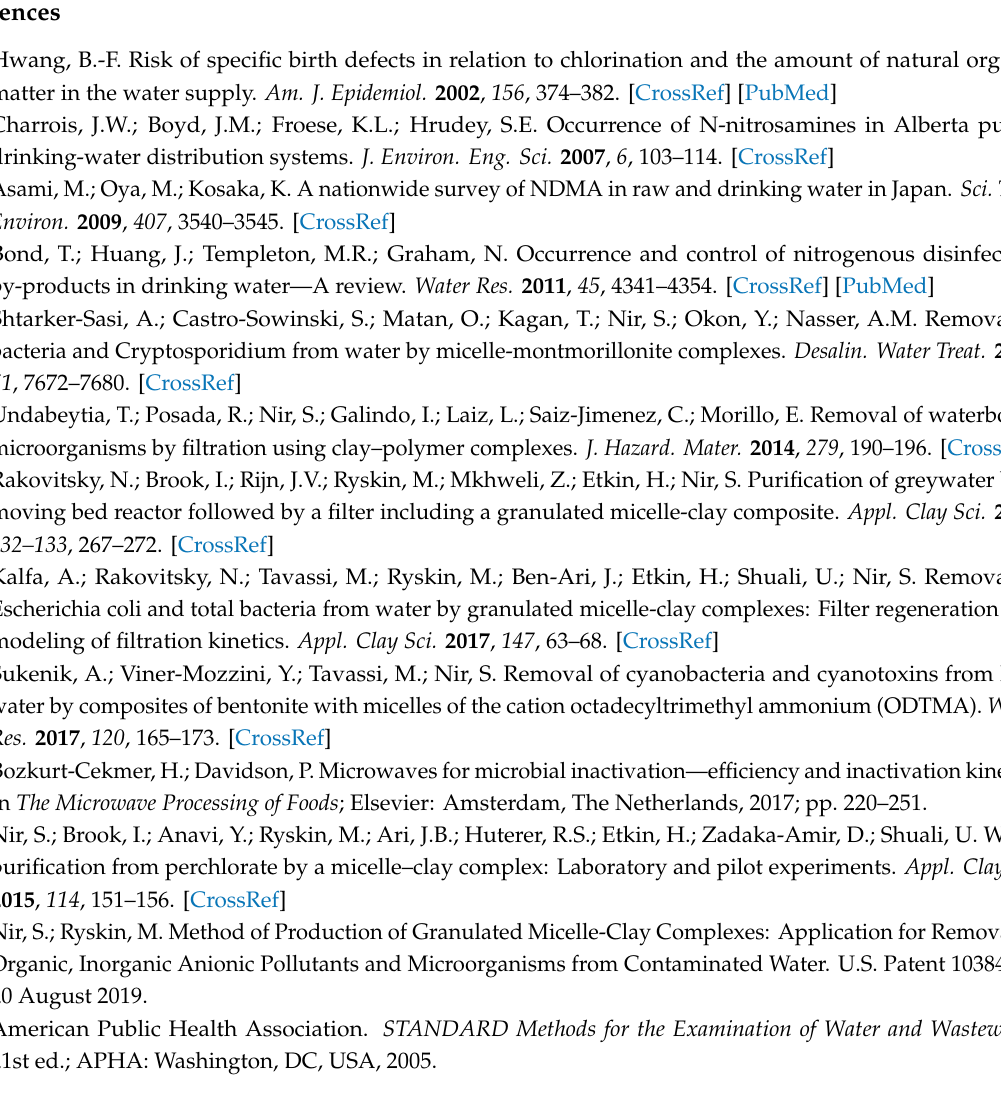
Figure S1. (a) Thermogravimetric analysis of BDMHDA–c-Clay samples, no MW; (b) Thermogravimetric analysis of BDMHDA–c-Clay samples with MW treatment; Table S1. Removal of total bacteria count by fresh micelle-clay granulated complex by filtration (CFU per mL) *; Table S2. Removal e ffi ciency of total bacteria count by ODTMA–c-clay fresh granules: filtration of 8.6 L after stopping for 20 days followed by filtration after MW regeneration (CFU per mL); Table S3. Removal e ffi ciency of TBC by ODTMA- granules after third regeneration (CFU per mL): number of emerging bacteria after filtration of given volumes